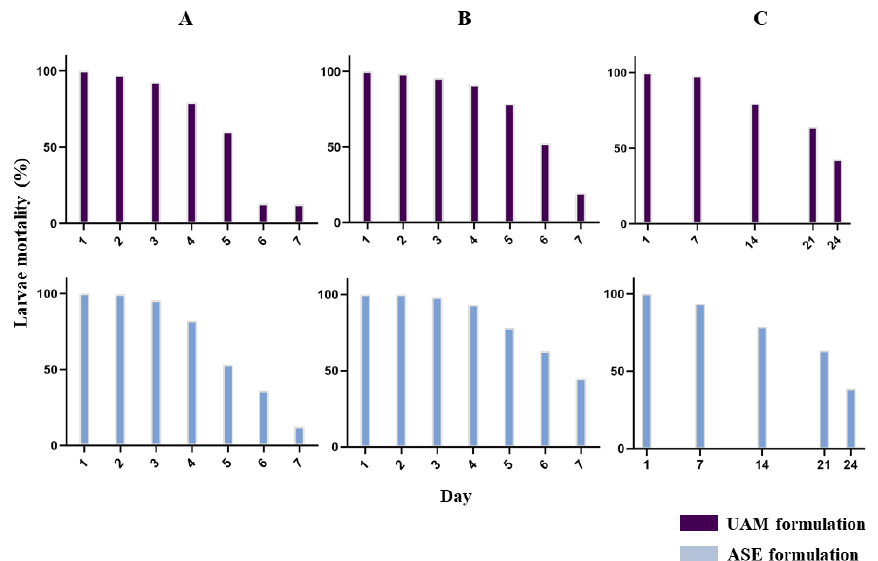
Figure 7. Small-scale simulated field trial of Piper nigrum fruit ethanolic standardized (ASE) and ultrasound assisted maceration (UAM) extract formulations (granulated white sugar) against Aedes aegypti L3 larvae. ( A ) . 2.5 μg/mL. ( B ) . 5 μg/mL. ( C ) . 10 μg/mL. Both formulations caused 100% mortality on day 1 at all three concentrations. The assay was halted on day 7 for the 2.5 and 5 μg/mL formulations, as th e average mortality reached <50%. The 10 μg/mL assay, however, continued until day 24 when larvae mortal- ity dropped below 50% for both the ASE and UAM formulations (Table S16). On compar- ison with the activity observed in the piperine quantification test (7 days, Figure 4) (Sec- tion 3.5), it was possible to observe that the activity of the extract was maintained in the formulation and that 10 μg/mL provided prolonged residual activity until day 24 (>3 fold). A simple rapid incorporation process, which is beneficial in terms of cost effectiveness, is deemed favorable, particularly due to prolonged activity at 10 μg/mL. No records were found in the literature involving field or semi-field trails of black pepper against Ae. ae- gypti . Piper nigrum is available all around the world, known as “The King of Spices”, and is obtainable in large quantities. In 2020, Brazil ranked second in P. nigrum production. In 2018, a total of 752,000 tons were produced globally [27]. Extract yield and insecticidal activity at lower concentrations means that 1 kg of powdered P. nigrum could treat 6000 L of water. All these data provide evidence that a product developed on this basis could contribute to treating a huge public health concern. 3. Materials and Methods 3.1. Instrumentation and HPLC Analysis An ASE-150 (Accelerated Solvent Extraction, Thermo Fisher ® , Sunnyvale, CA, USA) apparatus with 100 mL stainless steel cells was used for extractions. A Waters HPLC sys- tem, photodiode array detector 2998, autosampler 2707 and binary HPLC pump 1525 (Wa- ters, Milford, MA, USA) were used for analysis and method validation. Chromatographic separation was performed using a Kinetex Biphenyl TMS end-capped column, 4.6 × 150 mm with 5 μm particle size ( Phenomenex ® , Torrance, CA, USA). The mobile phase con- tained 0.2% formic acid in water (phase A) or acetonitrile (phase B). The total run time was 21 min: gradient elution started with 40% phase B reaching 45% in 1 min, continued until 9 min when the phase reached 80%. Phase B was subsequently raised by 5% over 4 min (85%) and maintained for 3 min. After one more min, B reached 100%, before return- ing to the initial phase in 1 min, where it was maintained for 3 min. The 10 μL sample was injected at 1 mL/min.